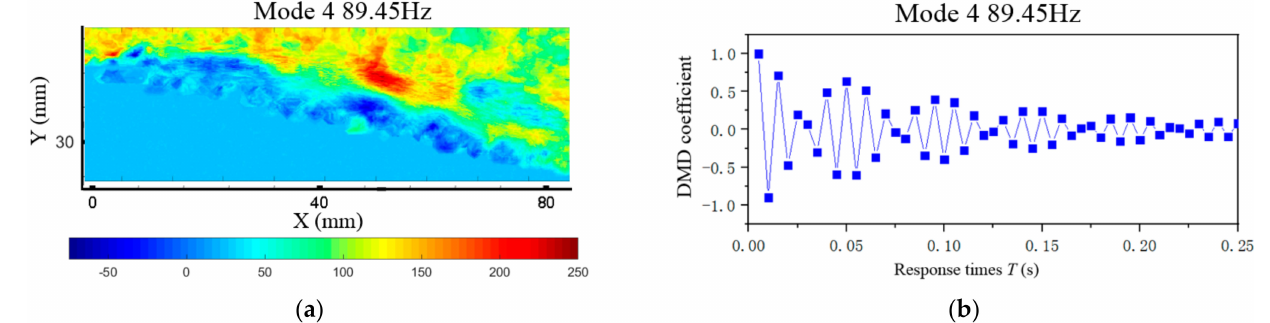
Figure 16. Fourth − order mode PSD = 89.45 Hz. ( a ) Decomposition results of the PIV velocity nephogram modal DMD in the Region A; ( b ) the DMD modal coefficient curve in the Region A.